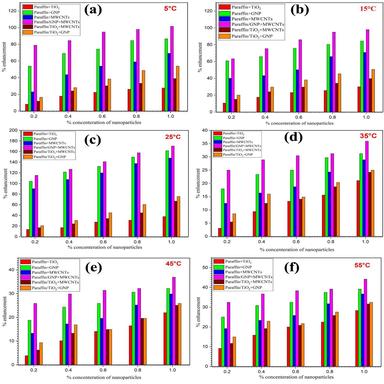
Impact of particles concentration on TC enhancement at different temperatures.